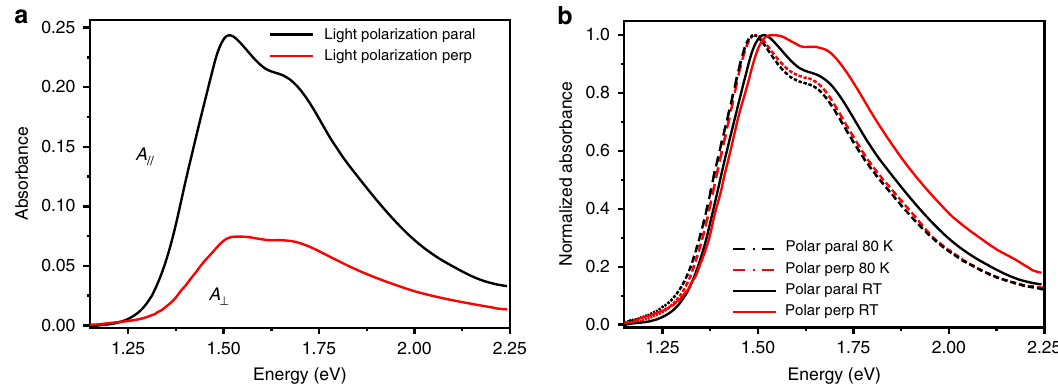
Fig. 1 UV – Vis and NIR absorption spectra. a Polarization-dependent spectra of an off-center spin coated, aligned DPPT-TT fi lm (from chlorobenzene solution, 10 mg/ml). b Normalized data of the polarization- dependent spectra at room temperature and at 80 K (trichlorobenzene solution, 10 mg/ml). The temperature dependence is reversible upon cycling (Supplementary Fig. 2). Light polarized parallel (polar paral, A // ) or perpendicular to the chain alignment direction (polar perp, A ⊥ )